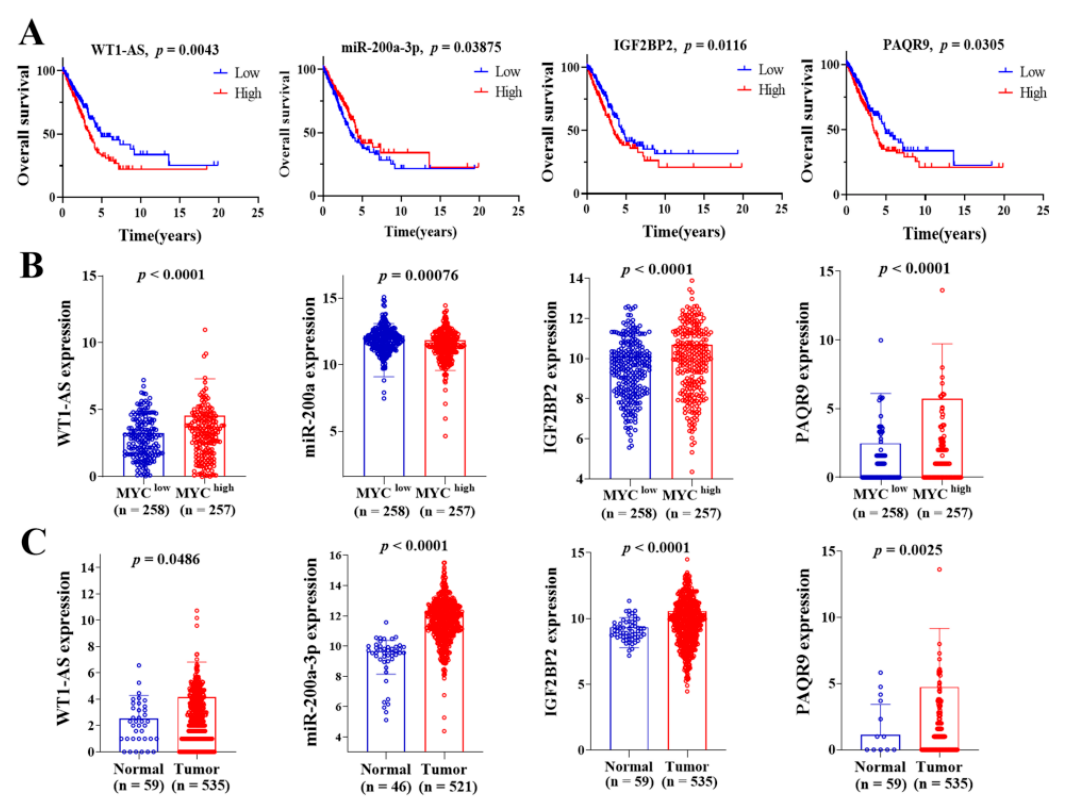
Figure 3. Correlation analysis of differentially expressed RNAs in the ceRNA network with overall survival of LUAD patients. ( A ) The high-expression and low-expression value of differentially expressed RNAs were compared by the Kaplan–Meier survival curve for the LUAD patient co- hort; ( B ) The expression pattern of differentially expressed RNAs in LUAD samples with c-Myc high and c-Myc low groups; ( C ) The expression pattern of differentially expressed RNAs in LUAD sam- ples and adjacent-normal lung tissues. The RNAs expression value was logarithmized with log2. p < 0.05 was deemed as statistically significant.